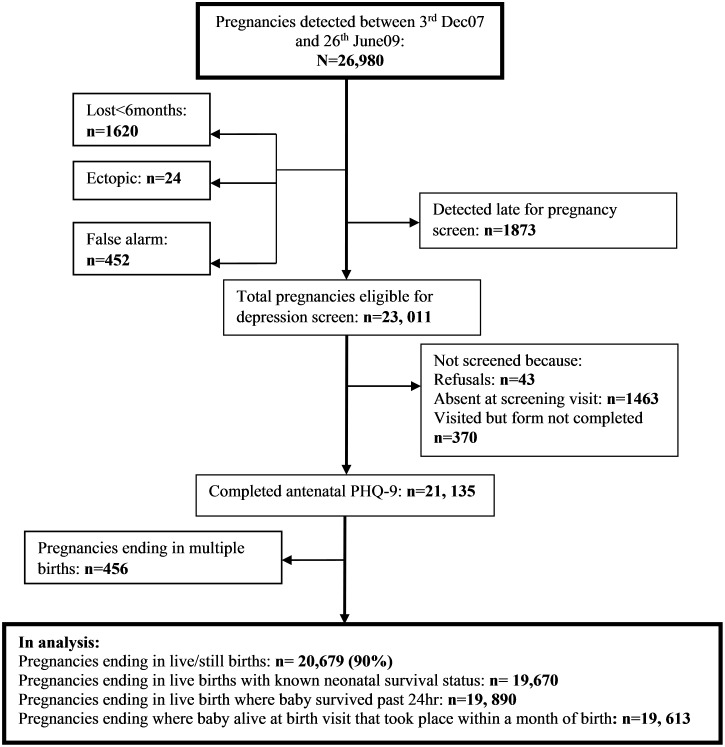
Recruitment profile. 1.
Lost<6 months: pregnancies lost before 6 months gestation. 2. Ectopic: tubal pregnancy. 3. False alarm: false report of a pregnancy by the mother. 4. PHQ-9: Patient Health Questionnaire.